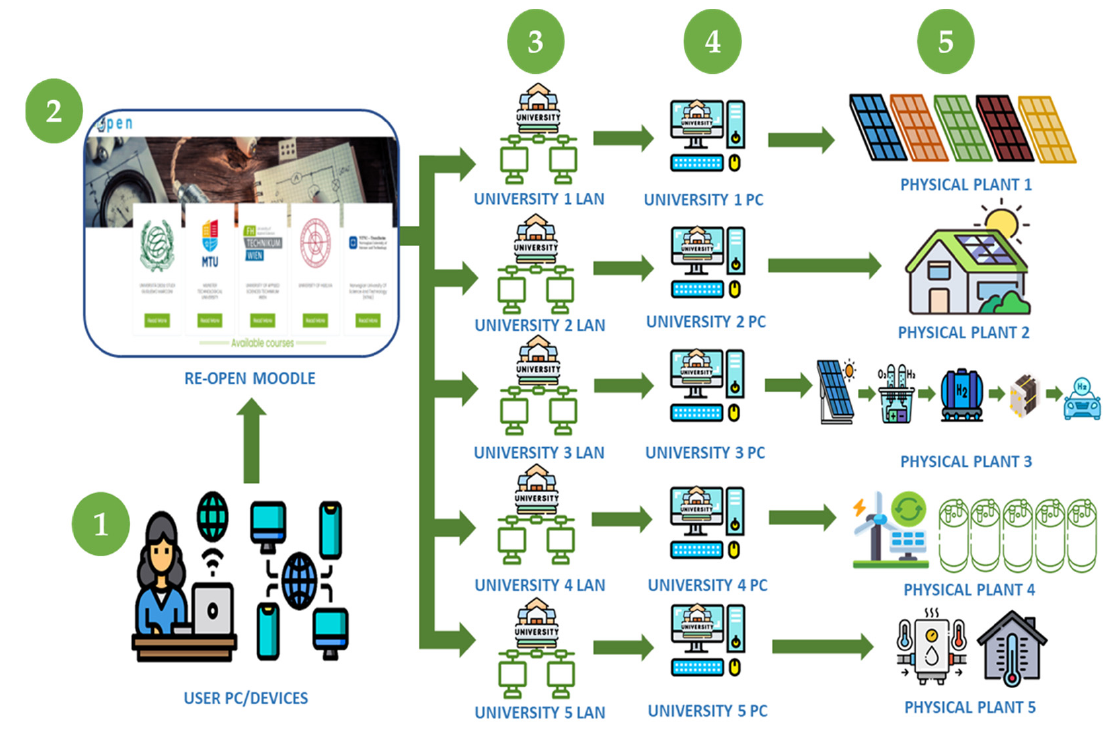
Figure 5. REOPEN ICT infrastructure standardization and collaborative network design.